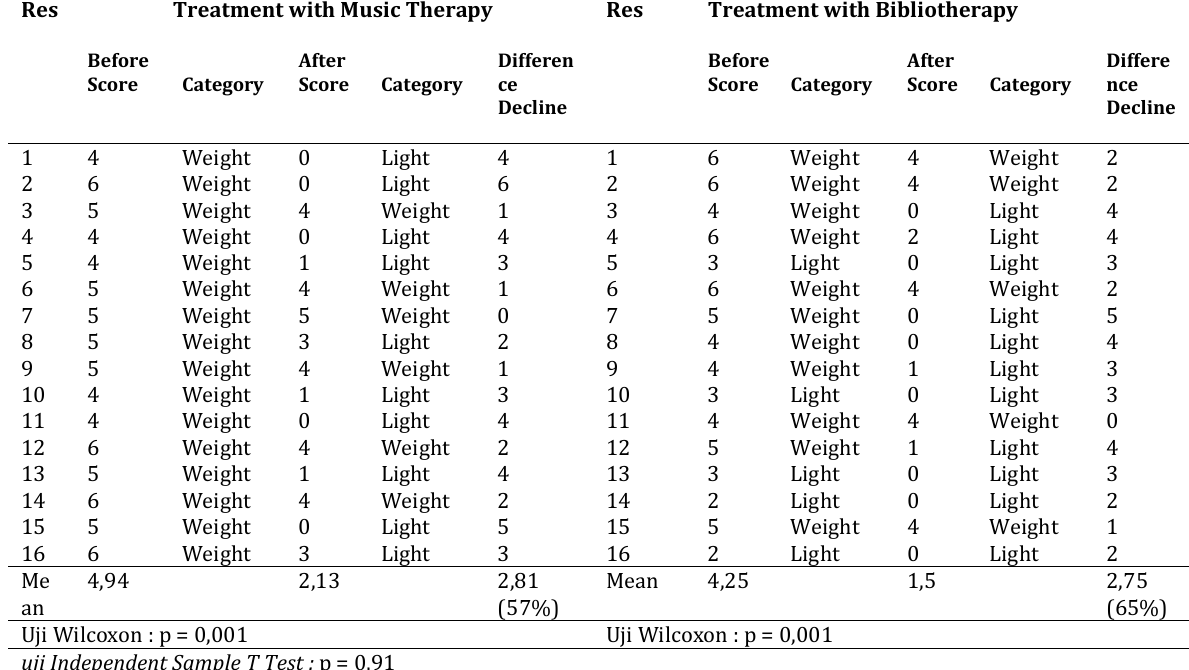
Table. 2. Anxiety Distribution of 3-12 year-old Children Patients who were given Intravenous Therapy Before and After were given Music Therapy in the Children's Room of Ratu Zalecha Martapura Hospital in